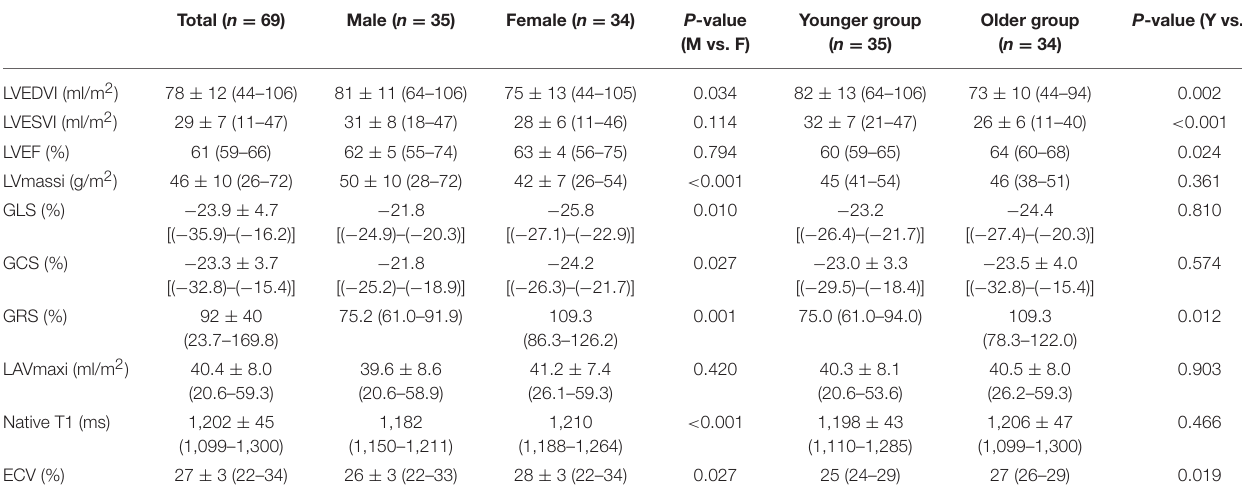
TABLE 2 | CMR parameters of a cohort of healthy adult Chinese